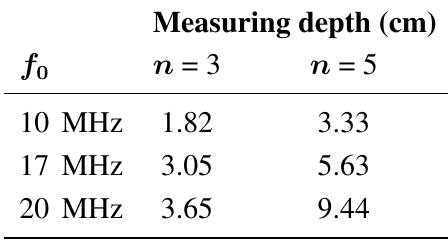
Table 3. Measuring depth for different base frequencies, f ( r = 30